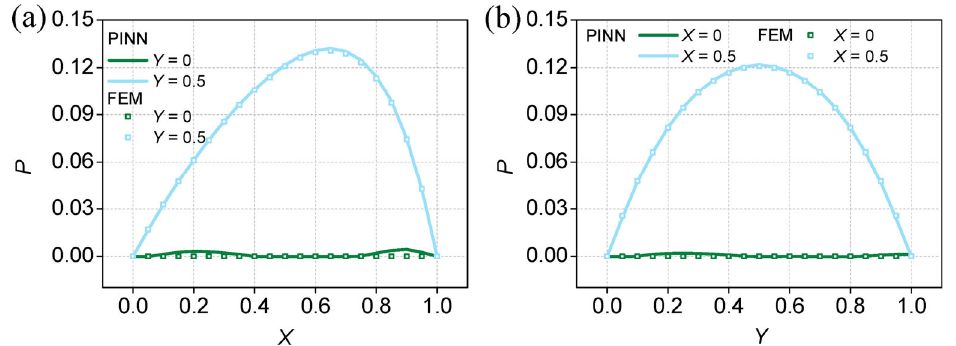
Fig. 15 Pressure comparison between PINN and FEM. (a) Along the entrainment direction. (b) Across the entrainment